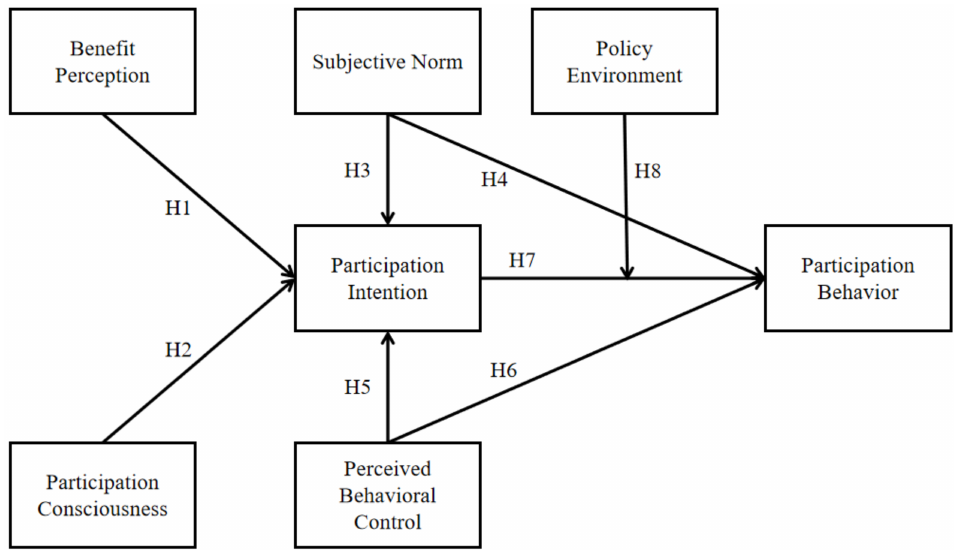
Figure 1. Research